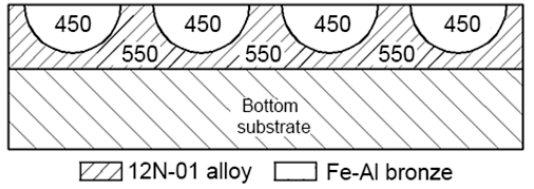
Figure 14. The scheme of microhardness changes in a single composite layer.